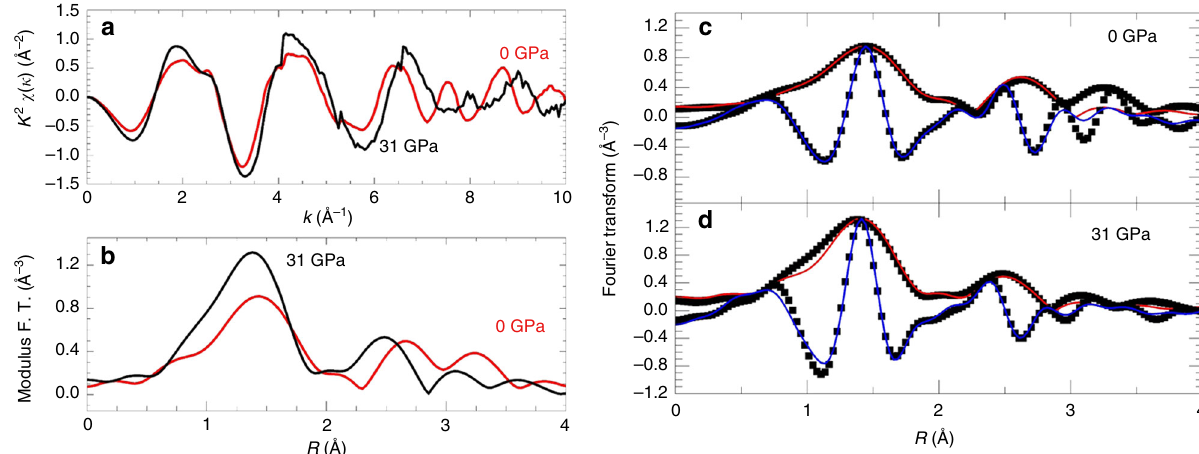
Fig. 4 Analysis of the EXAFS signals before and after the volume collapse. a k 2 χ ( k ) EXAFS signals and b FT at the Fe K-edge at ambient (red line) and 31 GPa (black line). The Fourier transformed k 2 χ ( k ) EXAFS signals at 0 GPa ( c ) and 31 GPa ( d ) are shown in black squares together with their best fi ttings of the modulus (red line) and imaginary parts (blue line) NATURE COMMUNICATIONS| (2018) 9:4554 |DOI: